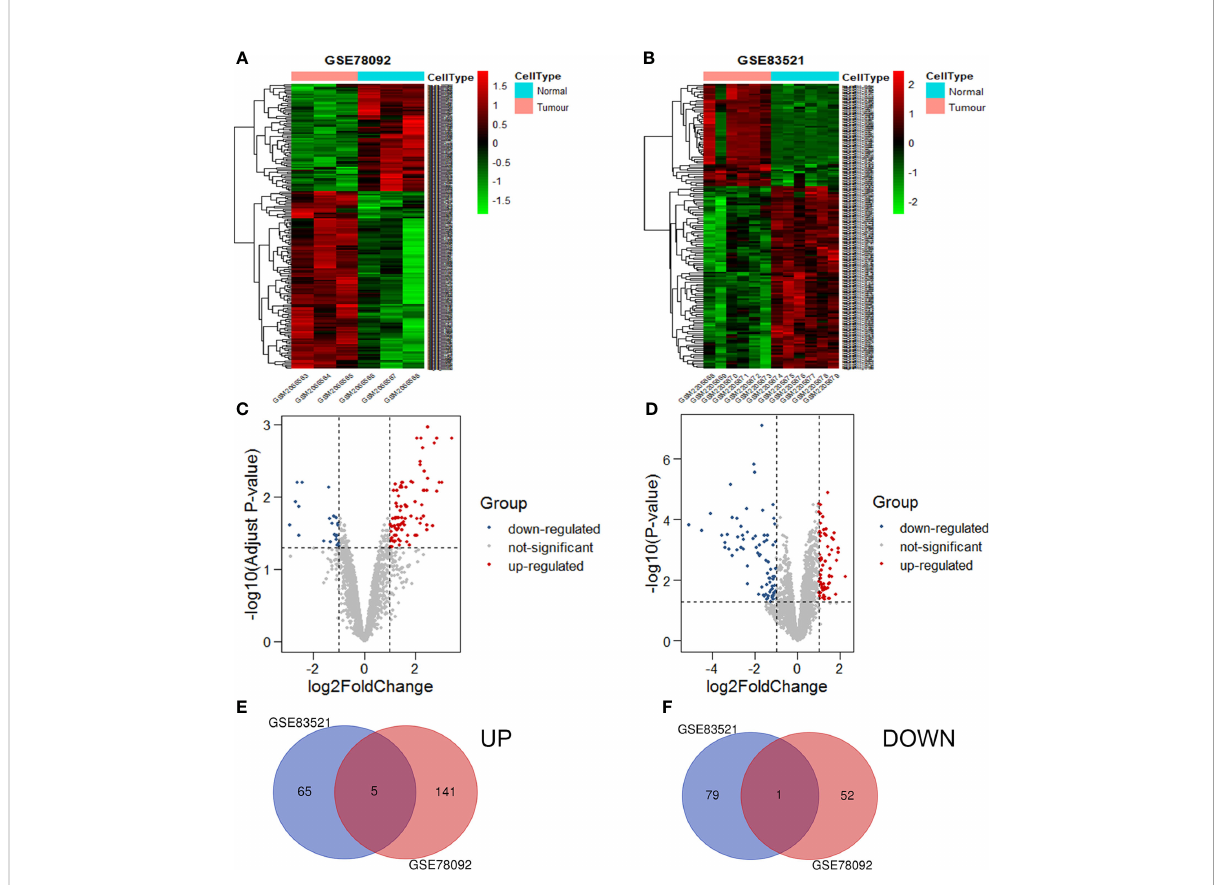
FIGURE 1 Volcanic maps and heat maps of circRNAs expression. The differential expression heat maps of GSE78092 (A) and GSE83521 (B) . The differential expression volcanic maps of GSE78092 (C) and GSE83521 (D) . Highly expressed circRNAs in the intersection of GSE78092 and GSE83521 (E) . Low expression circRNAs in the intersection of GSE78092 and GSE83521 (F)